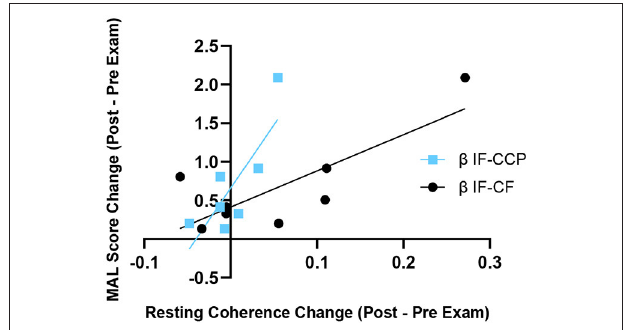
FIGURE 5 | Change in resting state β coherence vs. change in MAL score, from pre to post-HandSOME II therapy. Greater increases in IF-CCP and IF-CF resting state coherence correlated with greater MAL gains ( p = 0.006 and R 2 = 0.92, and p = 0.108 and R 2 = 0.64, respectively).